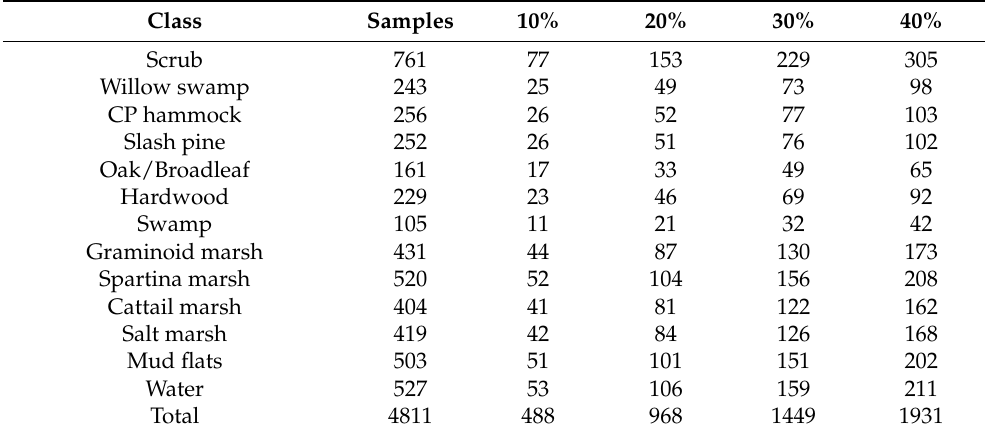
Table 3. The number of samples in each category of the Kennedy Space Center dataset and the division of training samples.